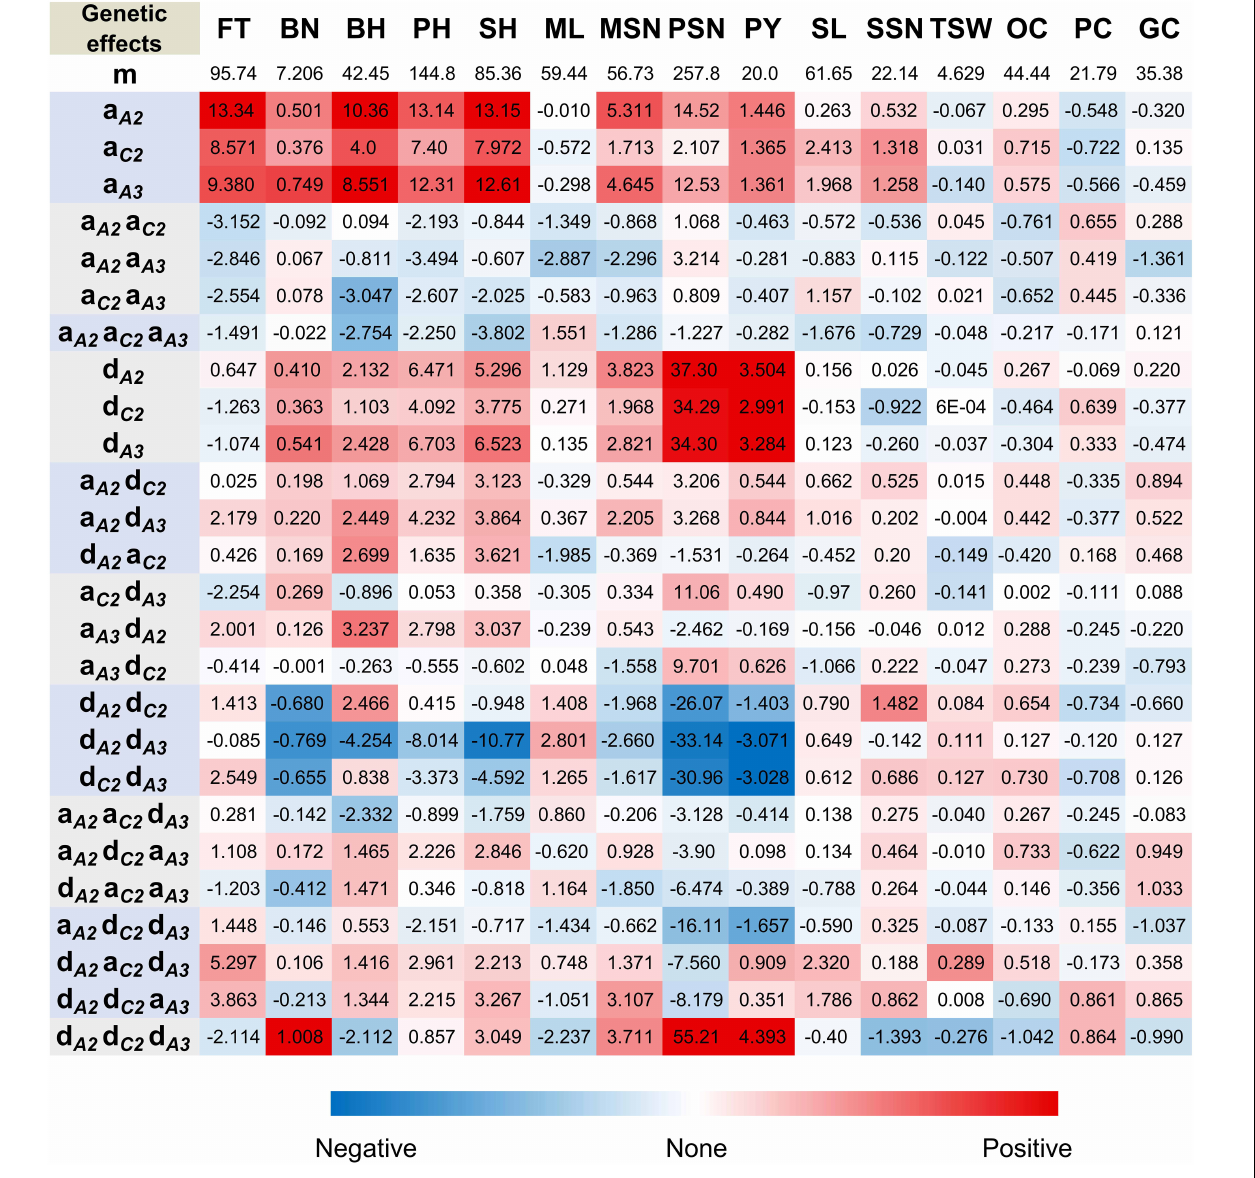
FIGURE 5 | Genetic analysis of the effects of BnFLC.A2 , BnFLC.C2 , and qFT.A3 ( BnFLC.A3b ). m, mean effect; a, additive effect; d, dominant effect; others, interaction effects; the footnotes A2 , BnFLC.A2 ; C2 , BnFLC.C2 ; A3, qFT.A3 ( BnFLC.A3b ); FT, flowering time (days); BN, branch number; BH, branch height (cm); PH, plant height (cm); SH, stem height (cm); ML, main raceme length (cm); MSN, silique number on main raceme; PSN, silique number per plant; PY, plant yield (g); SL, silique length (mm); SSN, seed number per silique; TSW, thousand seed weight (g); OC, oil content (%); PC, protein content (%); GC, glucosinolate content ( µ mol/g). The red color indicates positive effects, while the blue color indicates negative effects. Best linear unbiased estimation values of the phenotypes for the 15 traits of the 27 NIL genotypes in the Jiangling, Wuhan, and Minle environments were used in the